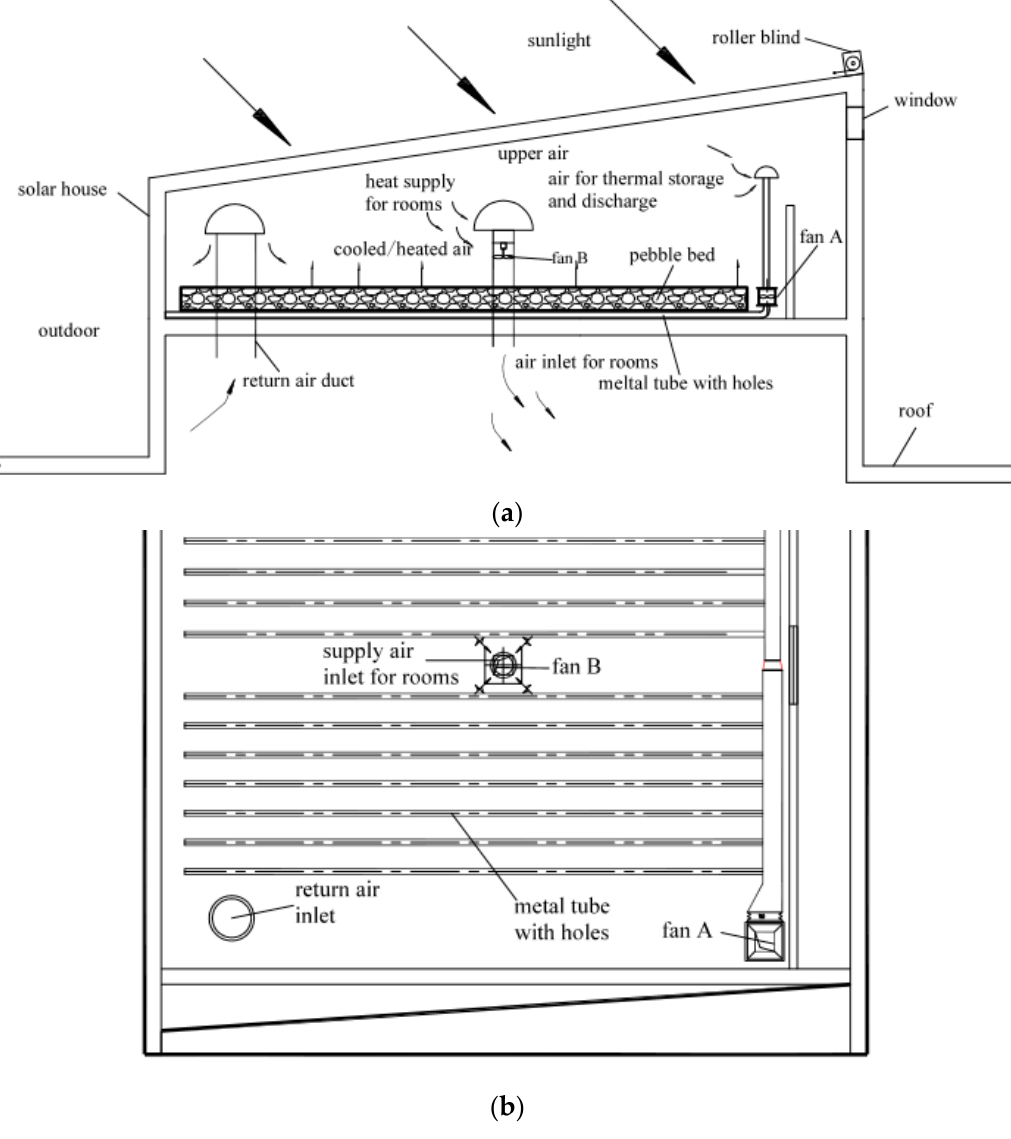
Figure 1. Schematic drawing of the pebble bed inside a solar attic for heat charge and discharge. ( a ) Side view; ( b ) Platform of the layout of air ducts under the pebble bed.